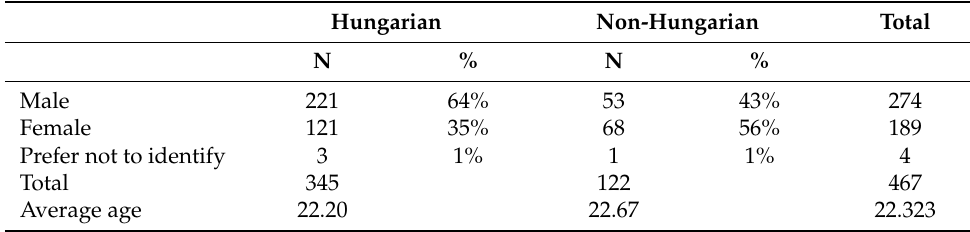
Table 1. Distribution of the sample by gender and nationality.